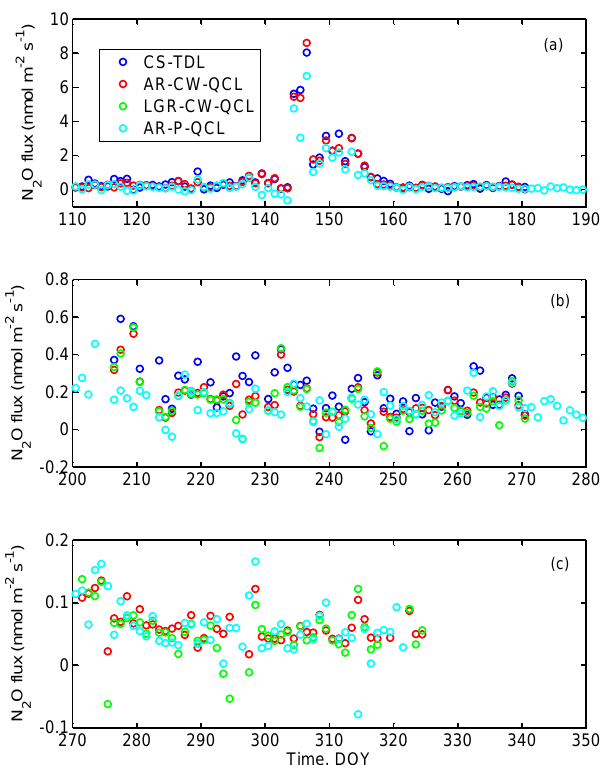
Figure 1. Daily average fluxes for four instruments containing pe- riod I DOY 110–181 (a) , period II DOY 206–271 (b) and period III DOY 272–324 (c) . No gap-filling was used in the calculation of daily average fluxes.